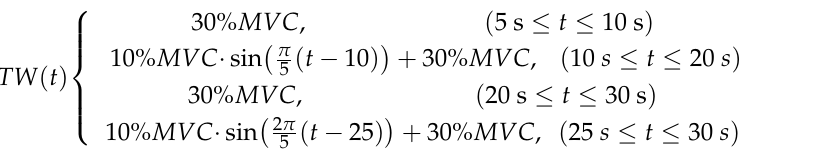
At each point in time, the grip force ( GF i ) of subject i was the sum of IFF i , MFF i , RFF i , and LFF i , as shown in Equation (3). IFC i , MFC i , RFC i , and LFC i represented the FCs of the four individual fingers of subject i . The following error ( FE ) of subject i was recorded as FE i . To determine the common mechanism and avoid any unique mechanism in specific subjects, the grip force, finger force, FC , and FE used for mechanism analysis were the average values for all the subjects. The expressions of mentioned parameters are listed